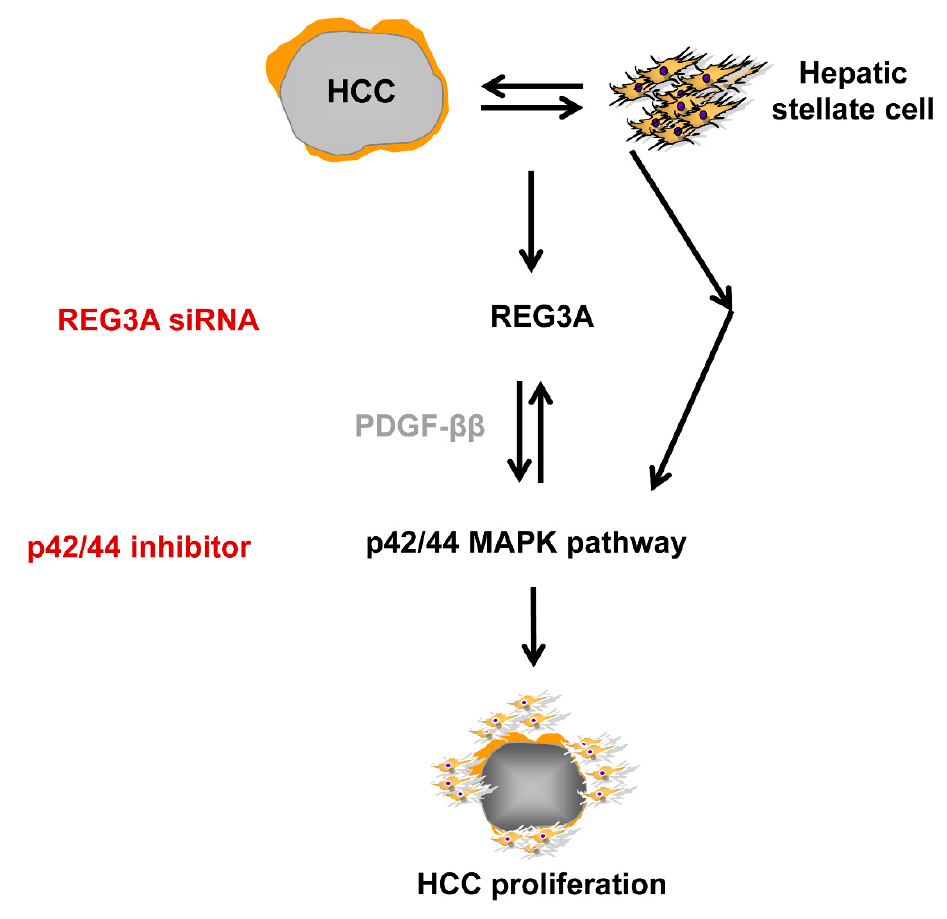
Figure 7. Graphical abstract. REG3A / p42 / 44 pathway / PDGF- ββ signaling plays a significant role in hepatocarcinogenesis via tumor-stroma crosstalk.